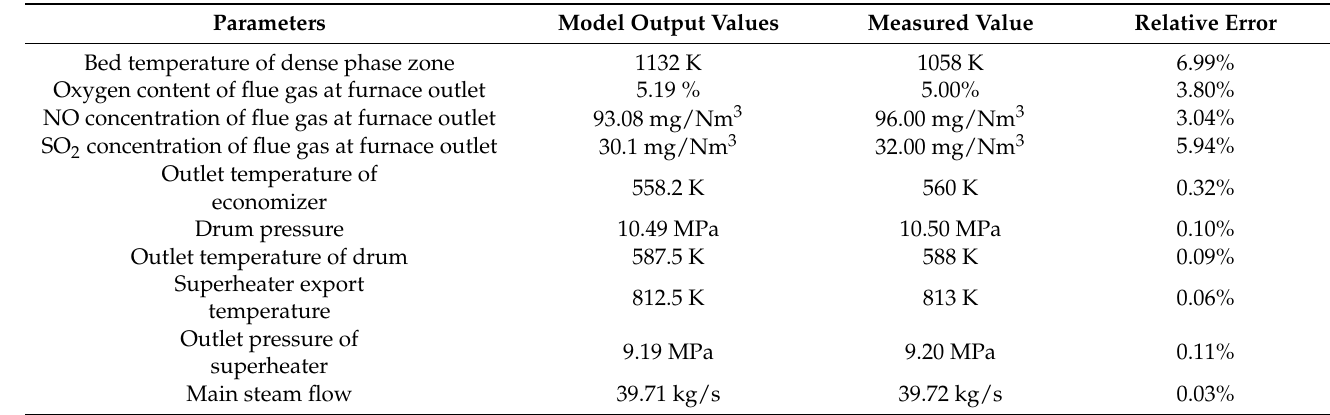
Table 2. Model reliability validation.